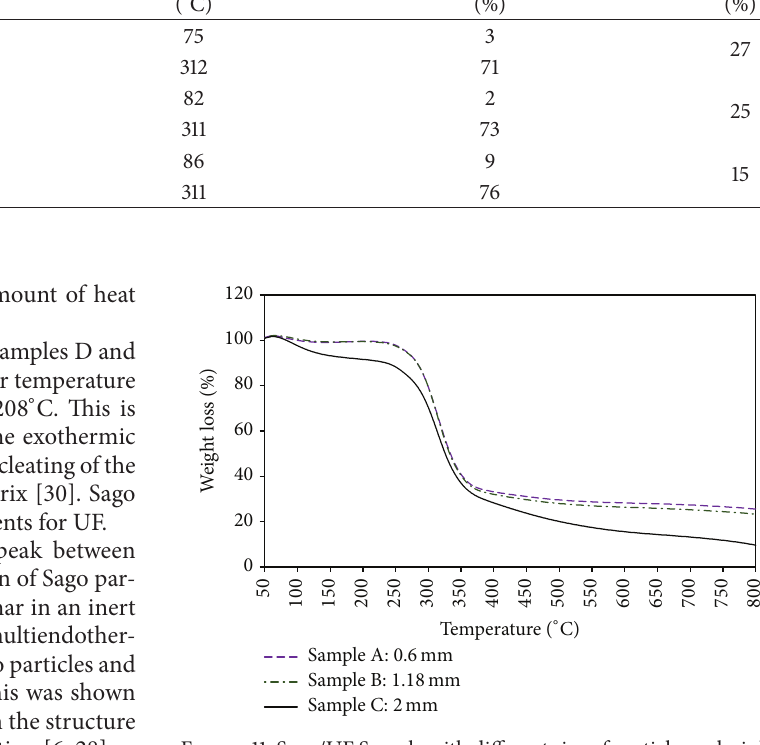
Figure 11: Sago/UF Sample with different size of particle analysis by